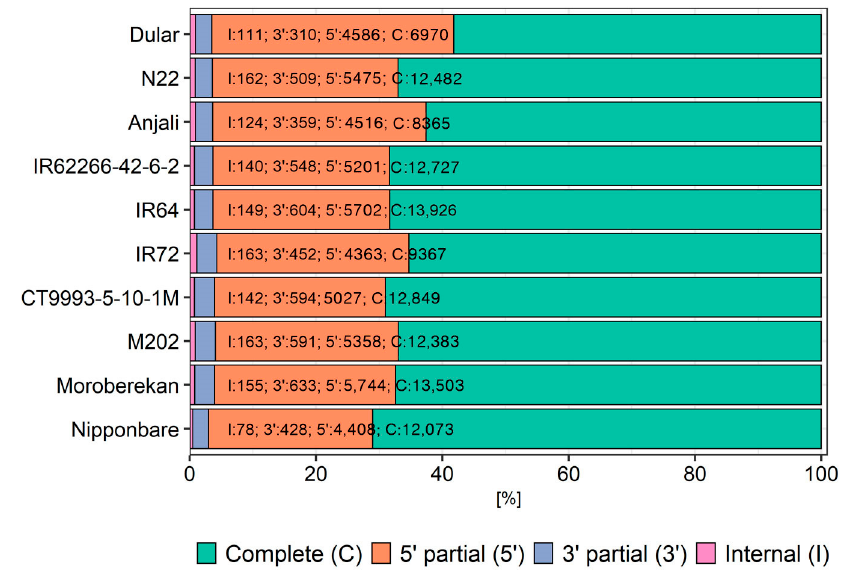
Figure 4. Fraction of predicted open reading frames (ORFs) using TransDecoder. Complete ORFs include start and stop codon, 5 (cid:48) partial / 3 (cid:48) partial ORFs contain only the start or the stop codon, respectively, and internal ORFs contain neither start nor stop codon. Numbers represent the number of transcripts for each category per cultivar. Cultivars were sorted alphabetically within the subspecies aus , indica and japonica .